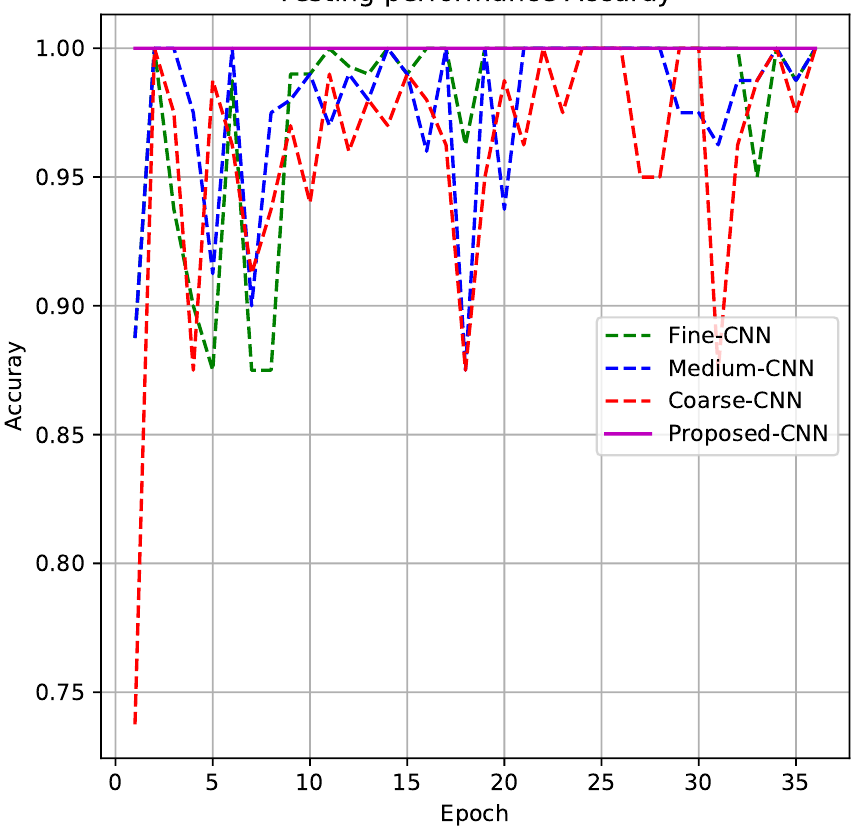
Figure 7. Testing results for the proposed CNN architecture.